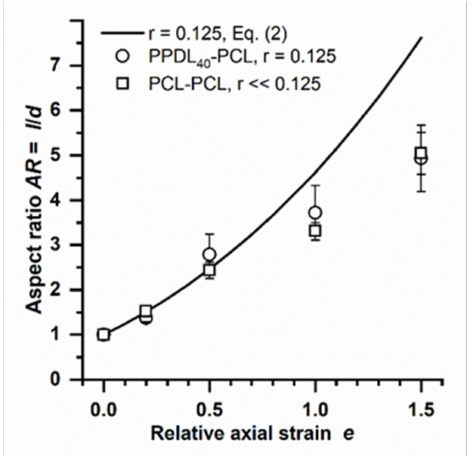
Figure 5. Experimental AR data of PPDL 40 -PCL and PCL-PCL in comparison to the deformation model (Equation (2)). Mean and S.D. of n ≥ 20